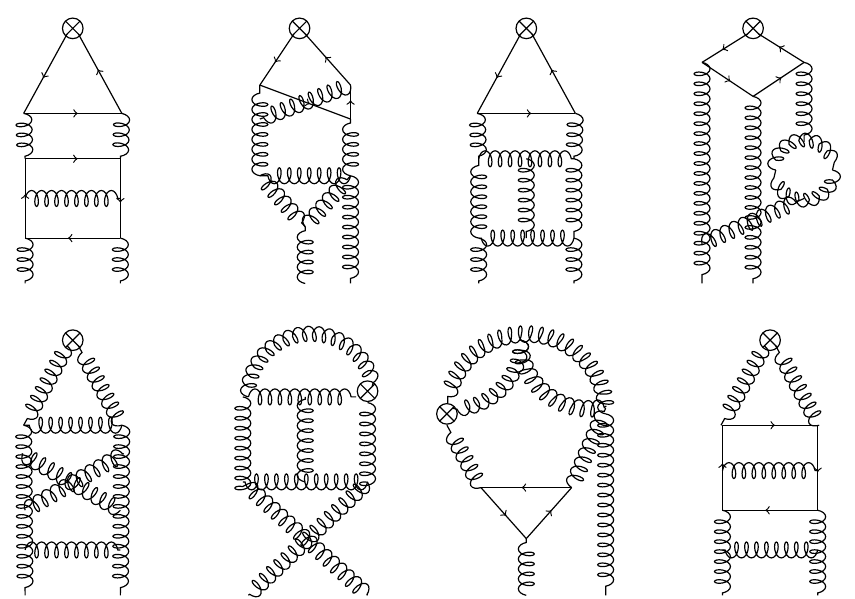
Figure 4 . Sample Feynman diagrams at 4-loop contributing to the matrix elements M lhs (upper row) and M (lower rhs